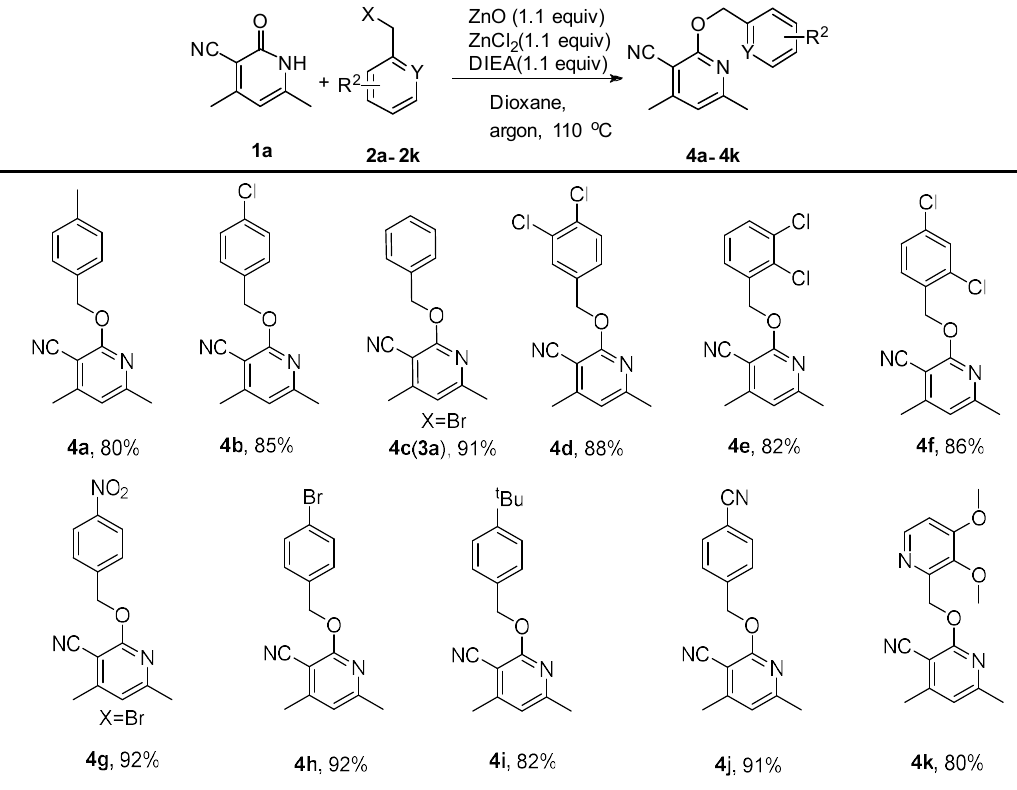
Table 3. Scope with respect to O -benzylation of 1a with substituted benzyl halides 1 .